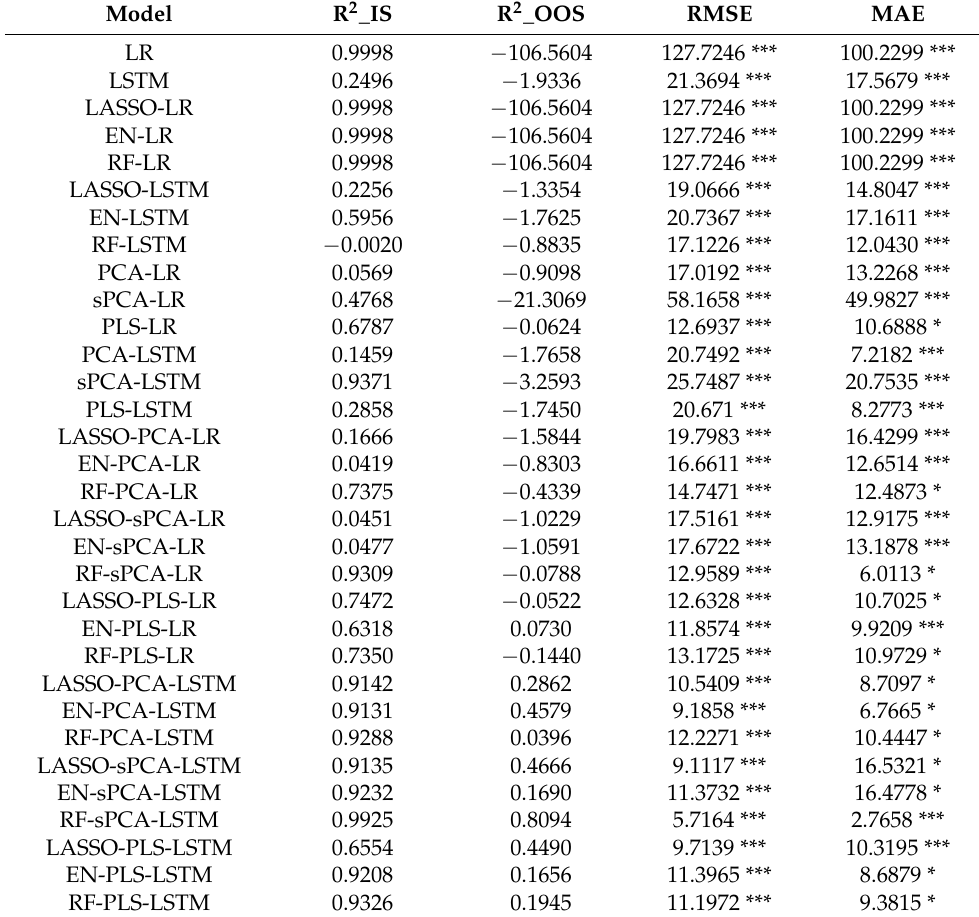
Table 10. Forecast results using monthly